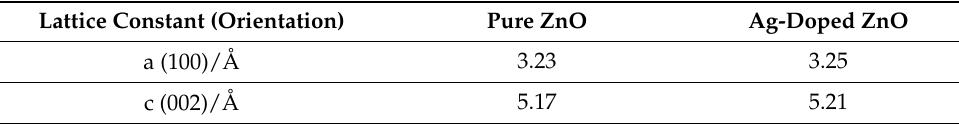
Table 1. Lattice constants a and c for pure and Ag-doped ZnO